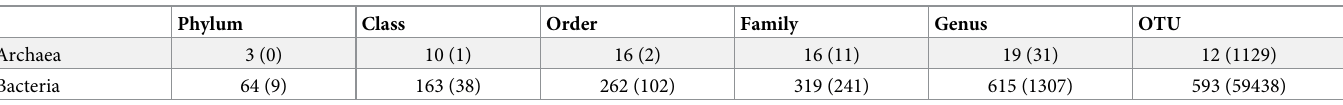
Table 2. Numbers of classified lineages within each taxonomic level used in the DAPC analyses. The numbers of unclassified lineages are in